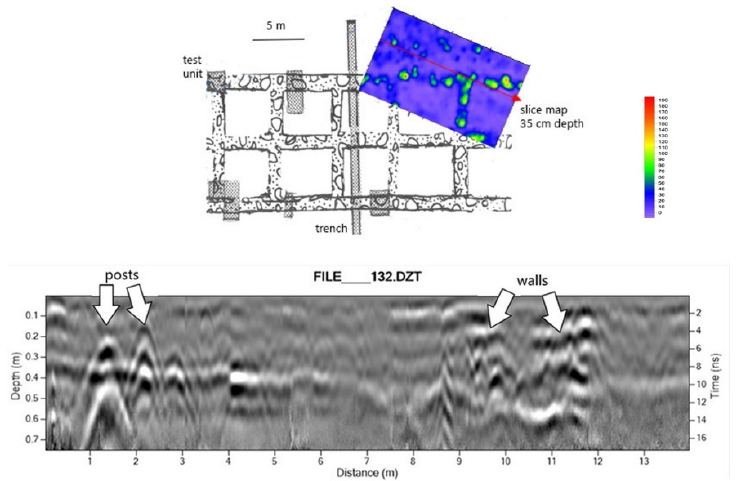
Figure 18. Mission San Juan Bautista, Taix Lot corredor post footings; transect runs from bottom to top of grid crossing walls at 9–10 and 11–12 m. Red line shows location of transect 132. (Base map after [1]).